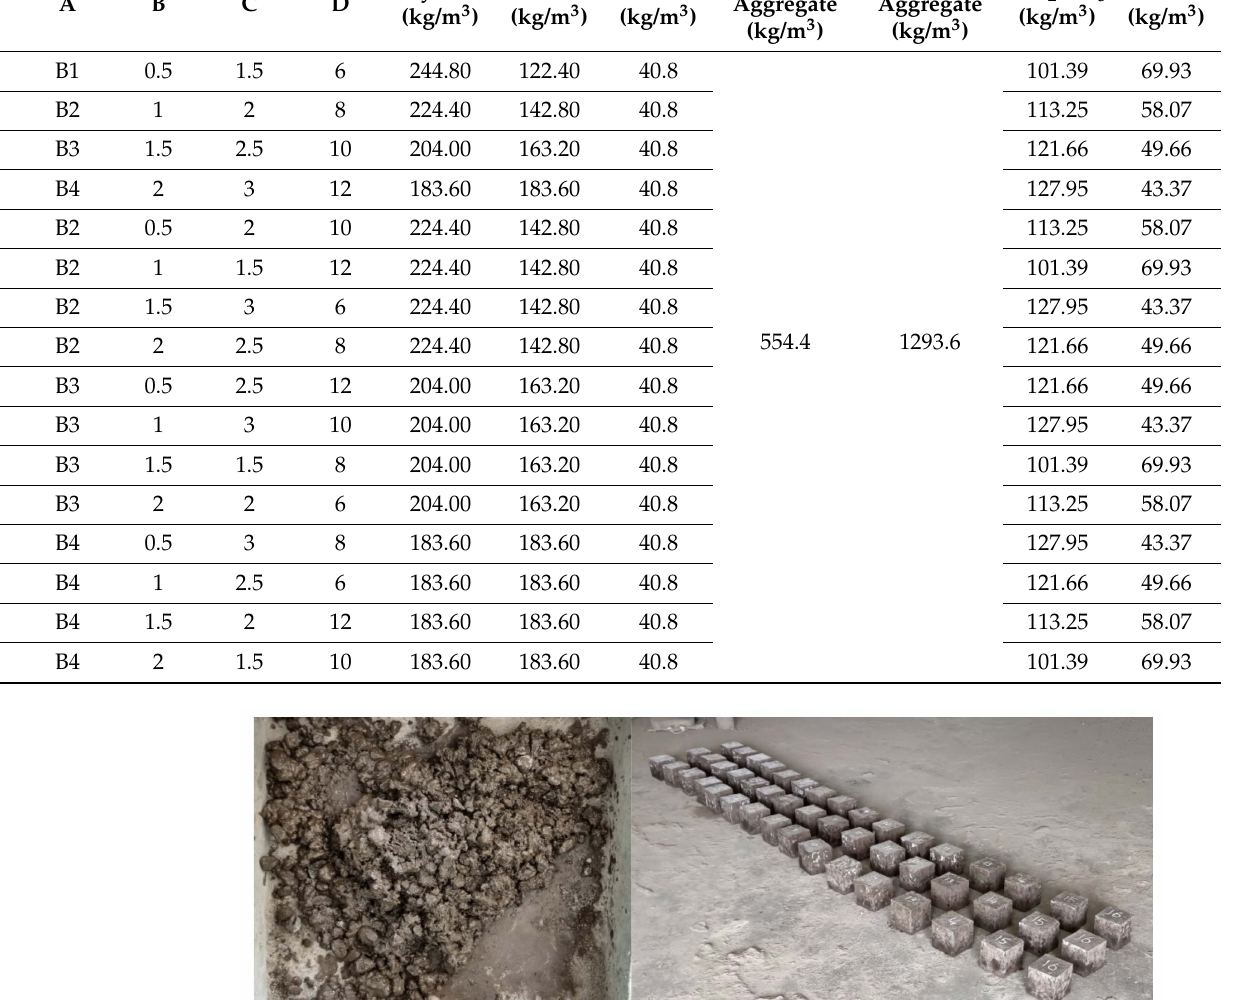
Figure 5. GPC mixture and specimens after